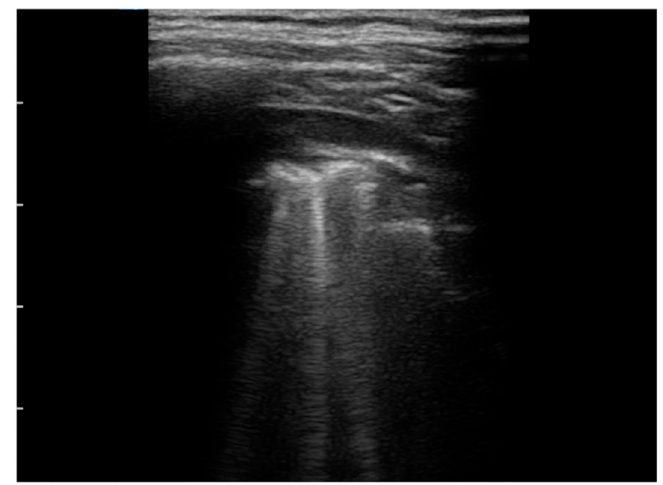
Figure 1. Pleural effusion < 1 cm, pleural irregularity and several B-lines.